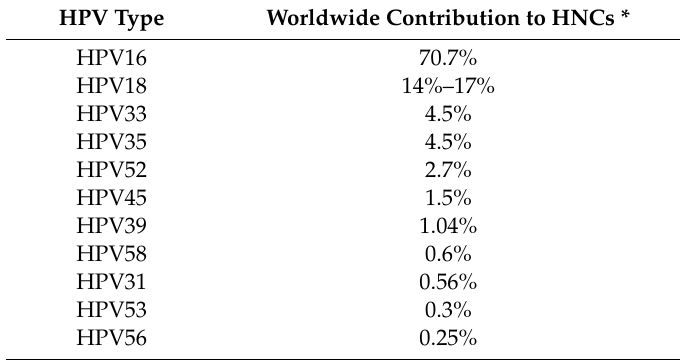
Table 1. The contribution of each human papillomavirus (HPV) type to head and neck cancer (HNC) cases worldwide.